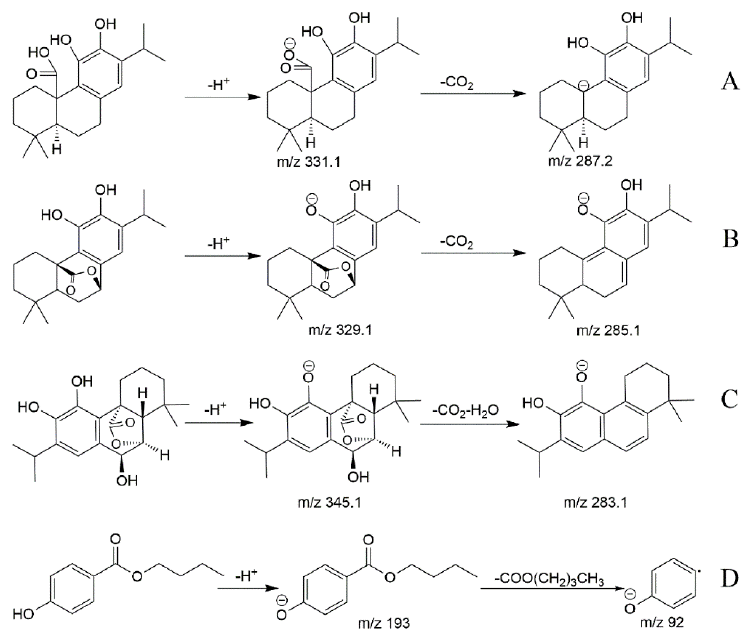
Figure 5. The possible fragmentation patterns of three analytes and I.S. in mass spectrometry: ( A ) carnosic acid; ( B ) carnosol; ( C ) rosmanol; ( D ) butylparaben.